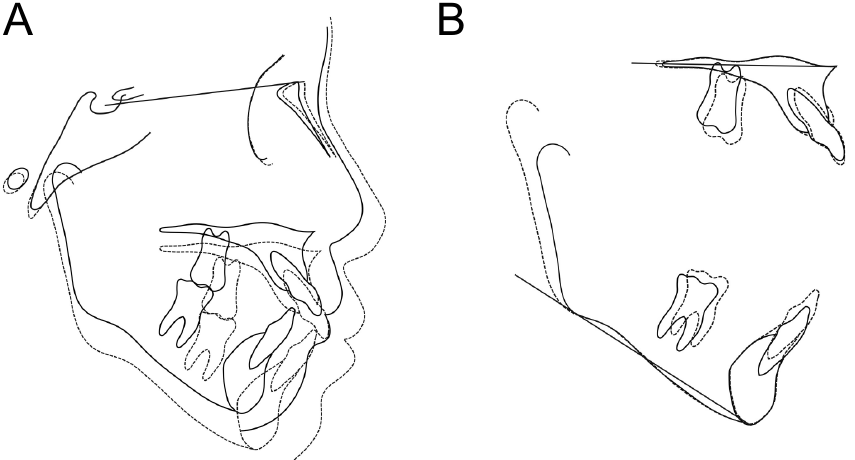
Figure 9. Superimposed images of Case 2; overall (SN plane, reference point S) ( A ); maxilla (palatal plane, reference point ANS) and mandible (mandibular marginal plane, reference point Me) ( B ).